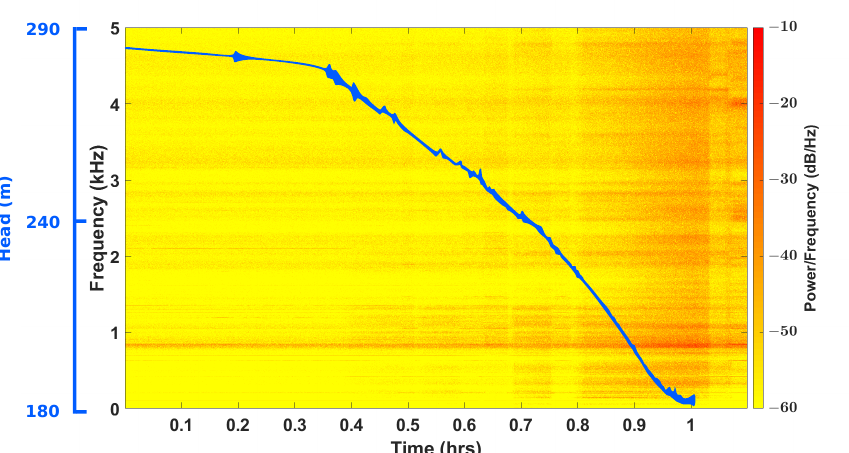
Figure 18. Spectrogram of the accelerometer along the x-direction during the third peak within the addition of the time history of the head (blue line). Water 2021 , 1 ,0